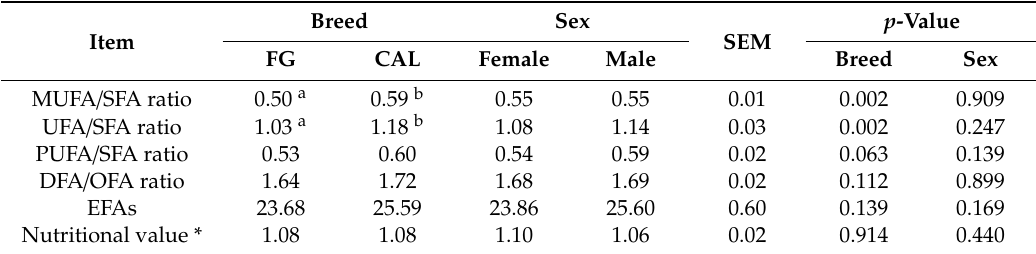
Table 5. Nutritional value of intramuscular fat ( Longissimus thoracis et lumborum ) in female and male Californian and Flemish Giant Gray rabbits (arithmetic means ±